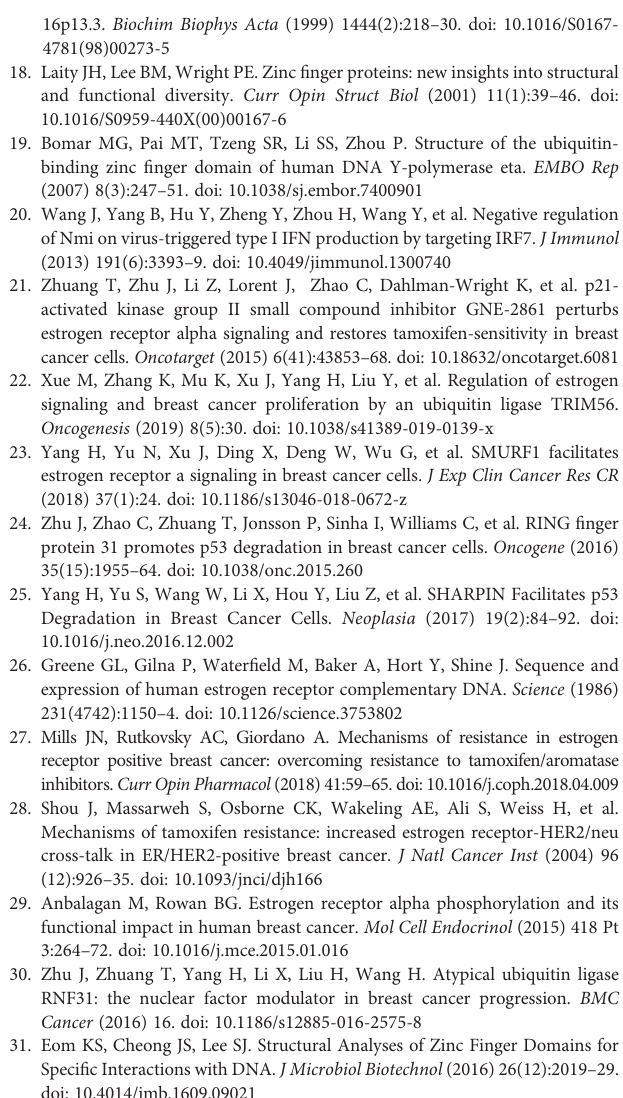
indicated siRNA. Quanti fi cation of wound closure at the indicated time points. Data are presented as ± SD. **P < 0.01 (student ’ s